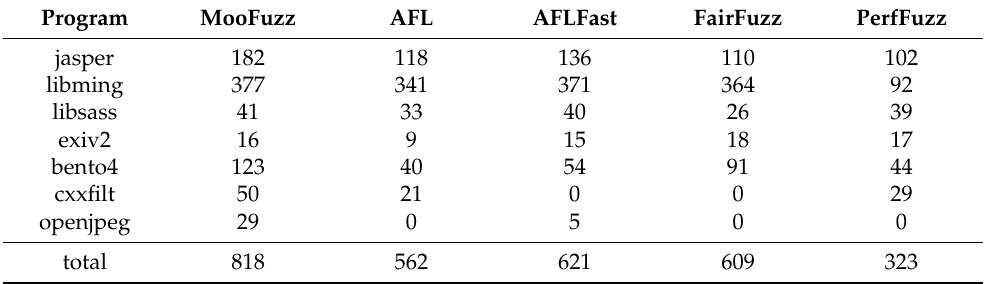
Table 3. Number of unique crashes found in real-world programs by various fuzzers.